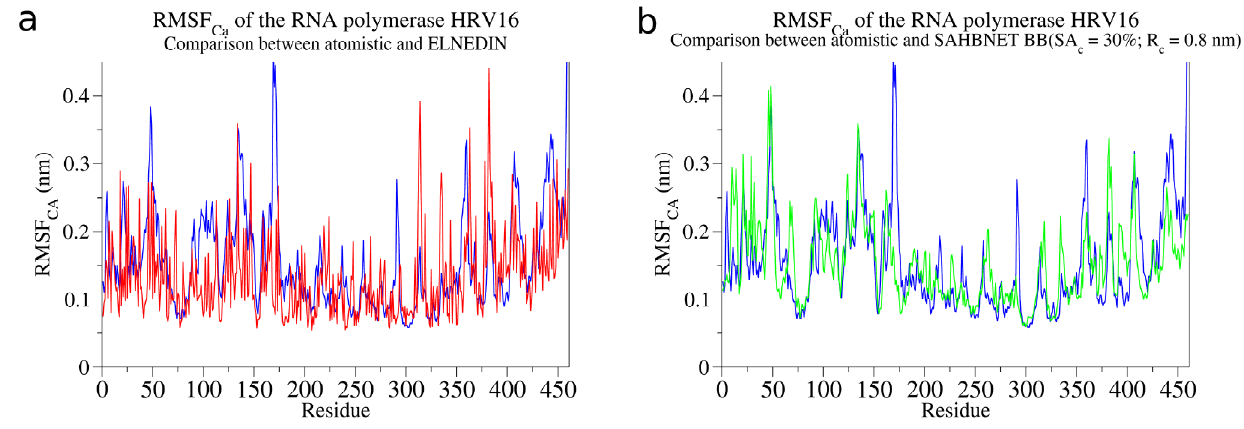
Figure 5. ( a ) Comparison of the RMSF of the C α between atomistic (blue), and ELNEDYN (red) ( b ) between atomistic (blue) and SAHBNET (SA and K 1000 kJ/nm 2 ) for the simulations of the RNA-dependent RNA polymerases SPRING from human rhinovirus